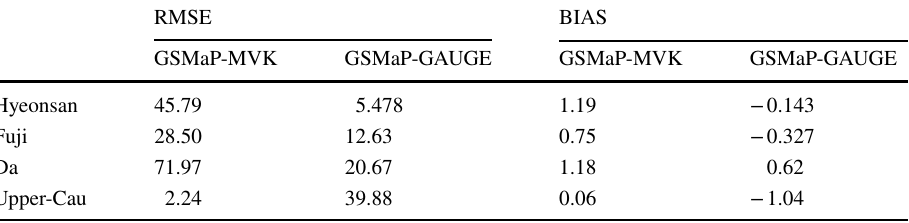
Table 3 Relationship between daily average precipitation over catchments between satellite- based precipitation and ground observations using statistics